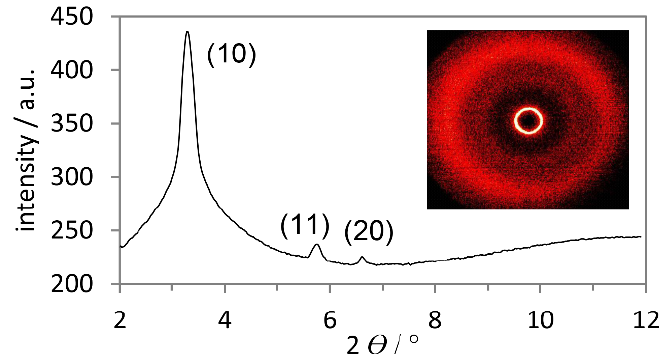
Figure 5. Small-angle X-ray scattering (SAXS) profile of the liquid-crystalline phase of 11e at 100 °C (Inset: wide-angle X-ray scattering,